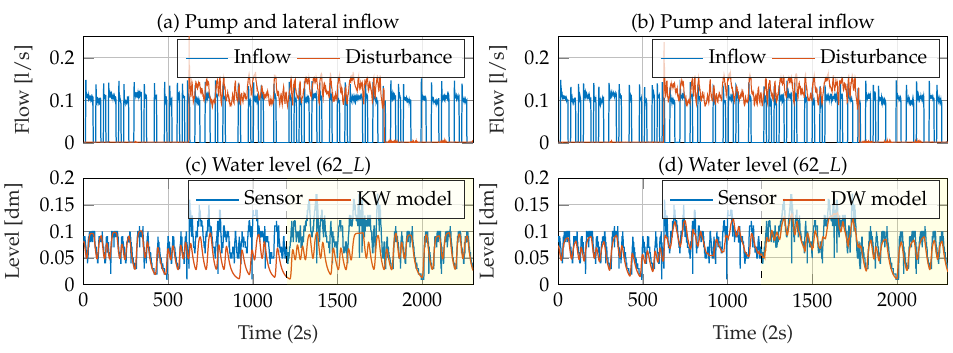
Figure 22. Graph from the experimental results of Ishøj’s study case [44], where the first part represents the system identification (training) and the second, in yellow, represents the